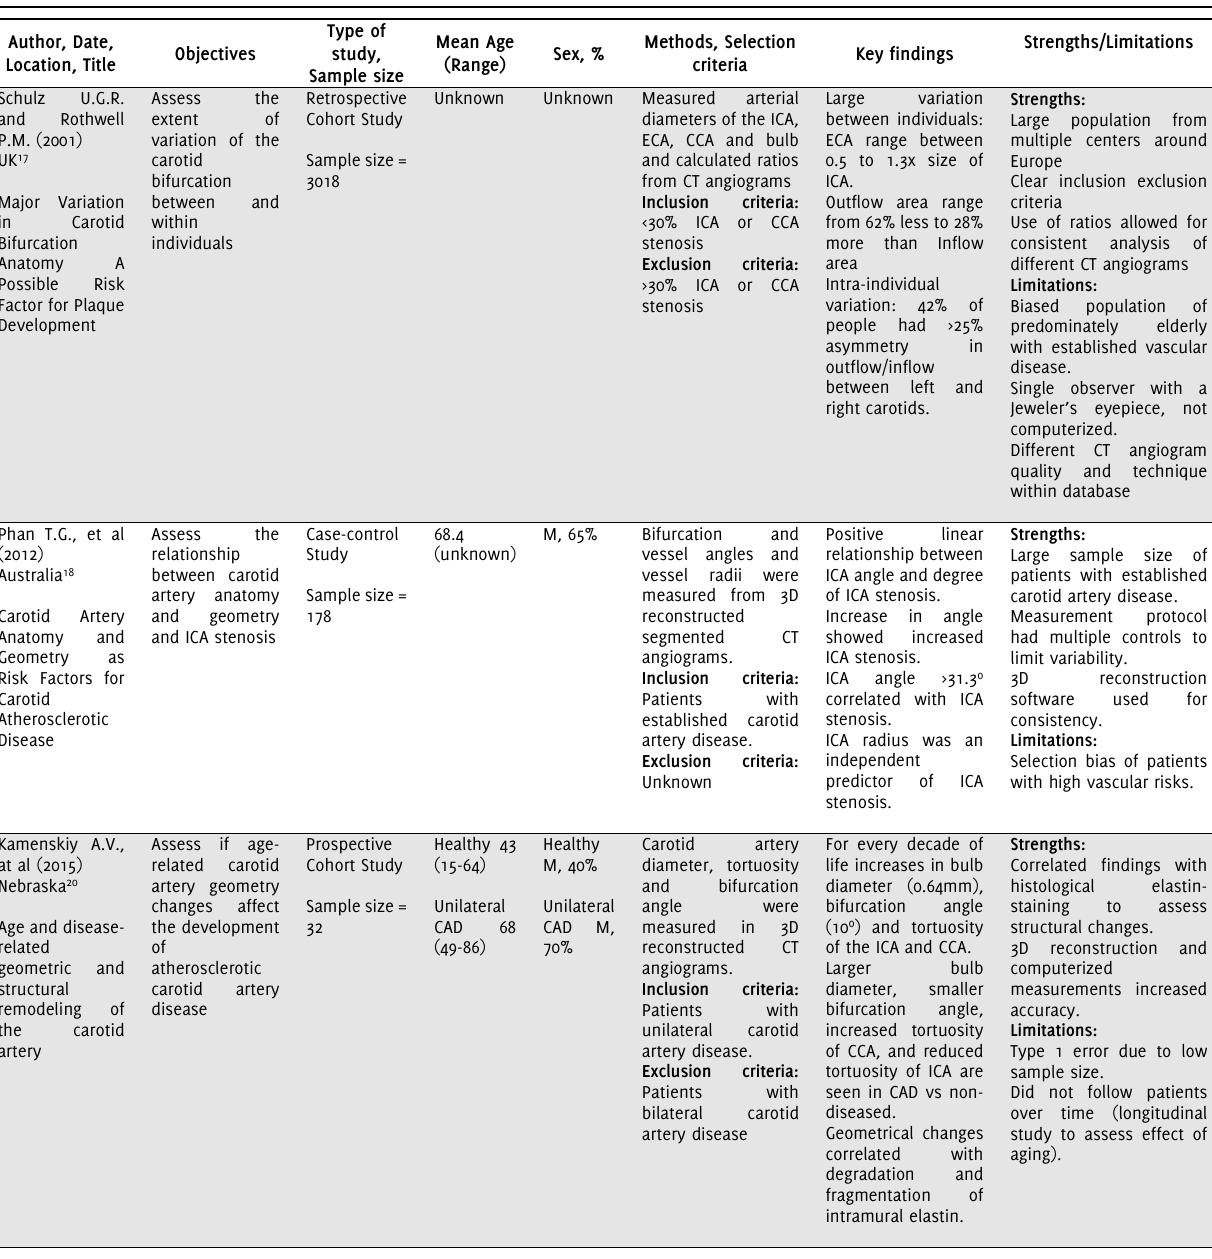
Strengths: Large sample size of patients with established carotid artery disease. Measurement protocol had multiple controls to limit